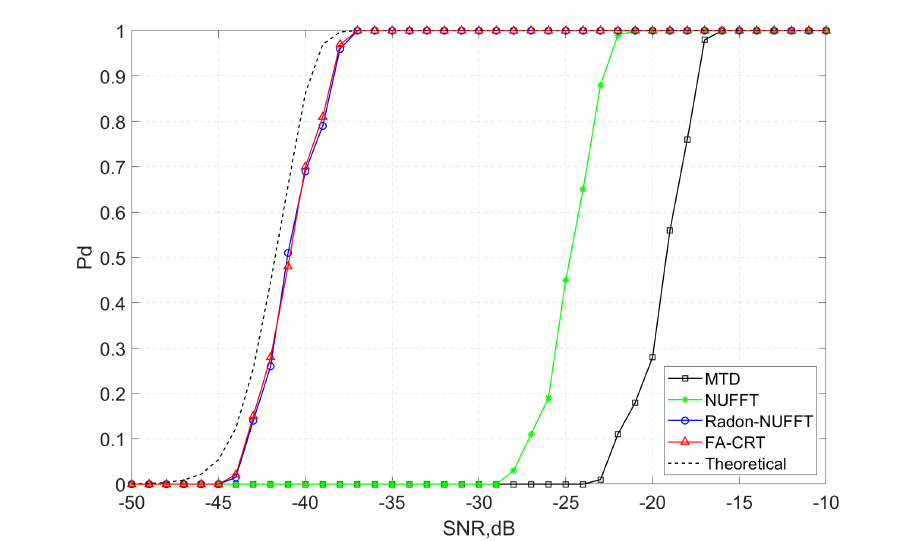
Figure 6. Detection probability of MTD, NUFFT, FA-CRT, Radon-NUFFT and theoretical coherent integration.